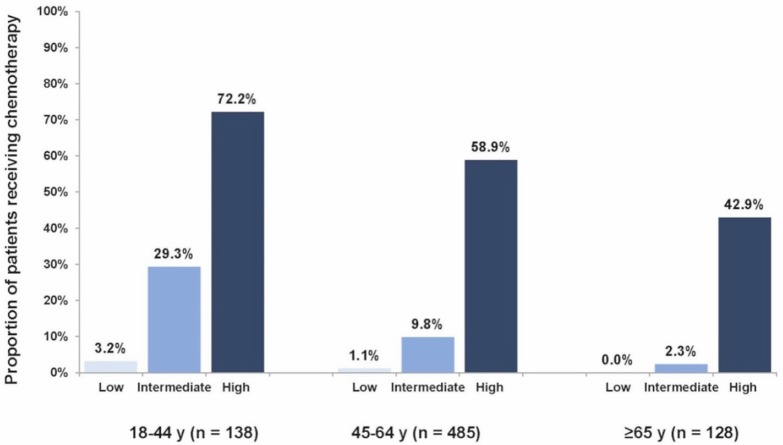
Proportions of patients receiving chemotherapy by age group and Recurrence Score category. Increase from each Recurrence Score level to the next (P < 0.0001); decrease from 18–44 years to 45–64 years (P = 0.0043), from 45–64 years to ≥ 65 years (P = 0.039); logistic regression.